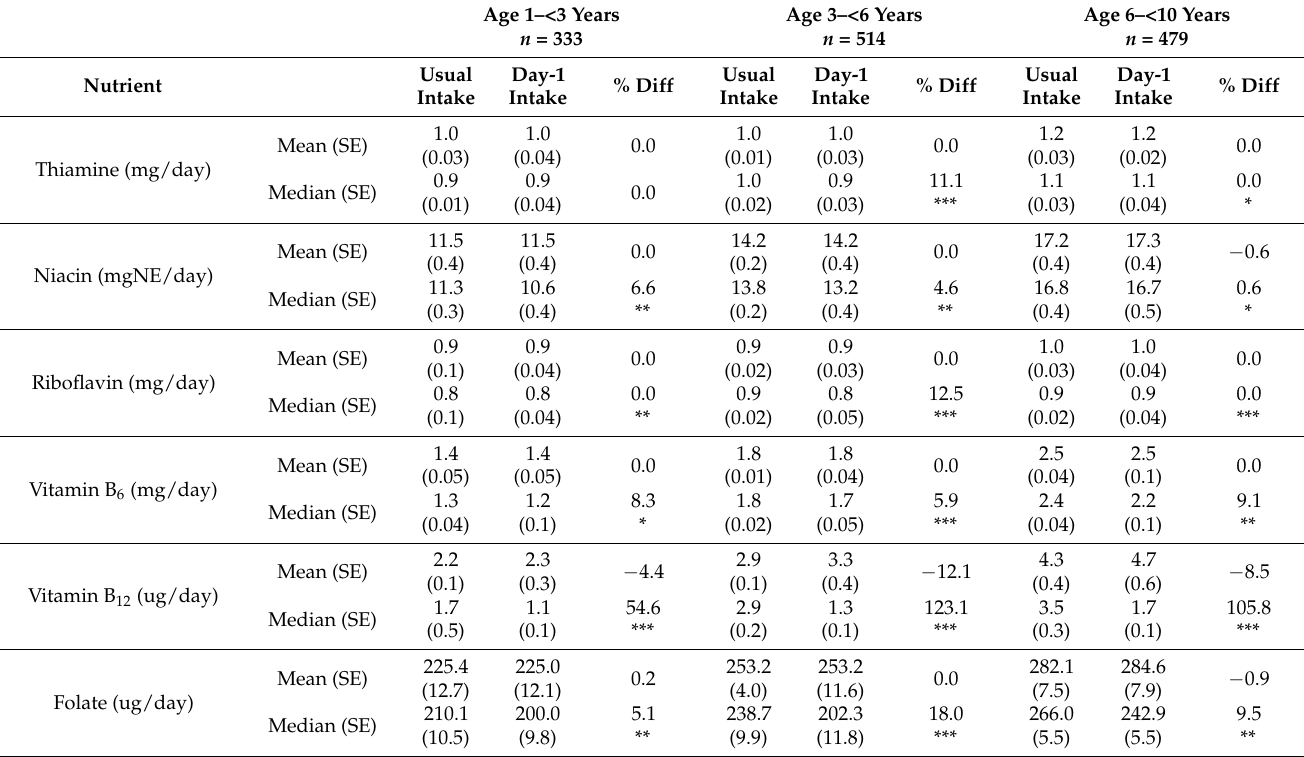
Table 9. Mean (SE of the mean), median (SE of median) and percentage differences (usual intake versus Day-1 intake) for thiamine, niacin, riboflavin, vitamin B6, vitamin B12 and folate intakes, by age